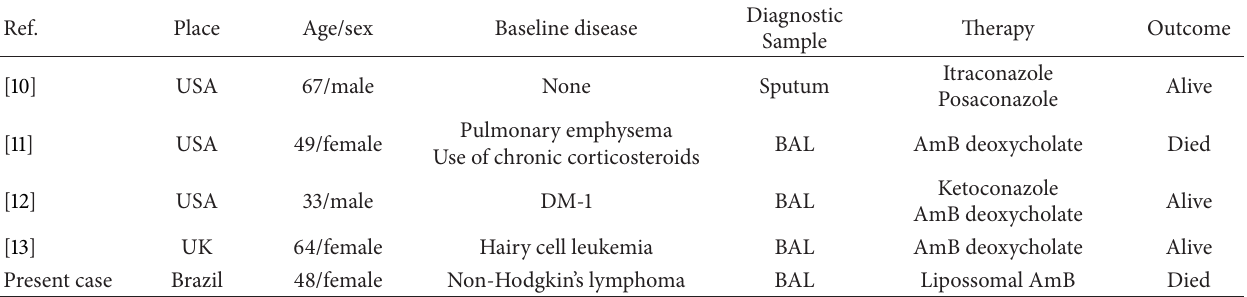
Table 1: Case reports of Paecilomyces variotii pneumonia described in the medical literature. Ref.